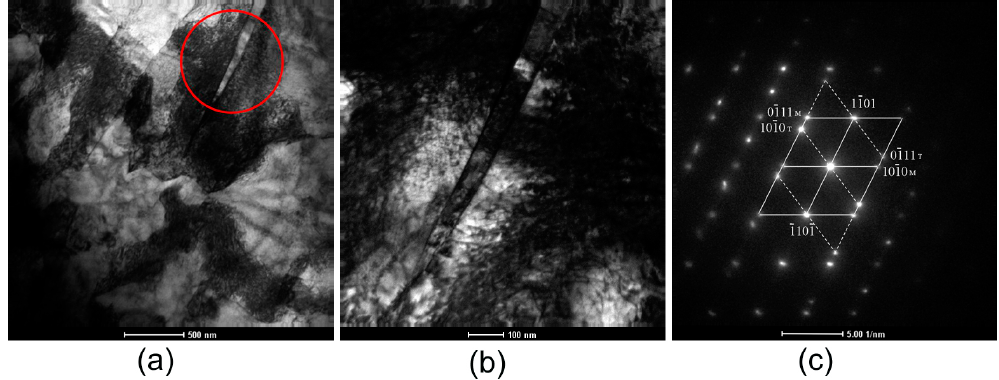
Figure 5. TEM microstructure of CP Ti processed by RD-ECAP for three passes showing { 1011 } twinning: ( a ) micrographs of spear-shaped twinning; ( b ) partial enlarged detail of the inner region of the red circle in (a); ( c ) the corresponding selected area electron diffraction for the [ 1213 ] zone axis.